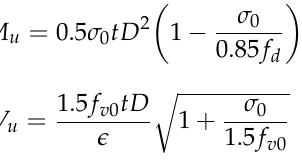
Figure 5. Numerical model of the global building: unifilar view ( a ); ( b ) extruded view. The chosen approach consists of modelling masonry panels, namely, the piers (vertical elements) and masonry spandrels (horizontal elements) as non-linear beams, connected to each other by rigid links, see Table A1. Masonry portions confined between piers and spandrels are modelled as rigid nodes. The nonlinear mechanical behaviour derives from a so-called lumped plasticity approach [23]. The masonry elements are modelled as elastoplastic, with two rocking hinges located at the ends of each frame and a shear hinge located at the mid-height. The masonry piers may suffer in-plane failure for bending– rocking and shear sliding mechanisms. The constitutive law is represented in Figure 6, and the failure criteria follow the Eurocode 8 (EC8-1) [24] and the Italian Design Code [25,26]: 2 evaluates the ultimate strength of the shear hinges.